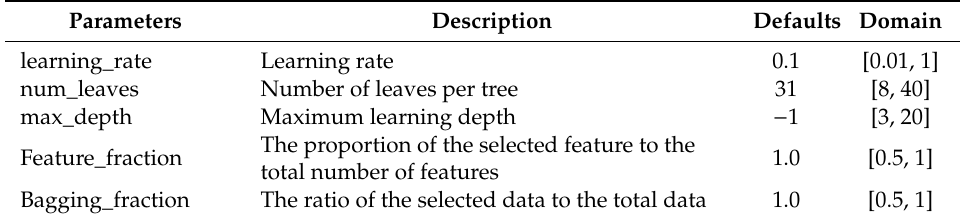
Table 4. Searching domain of hyper-parameters in LightGBM.